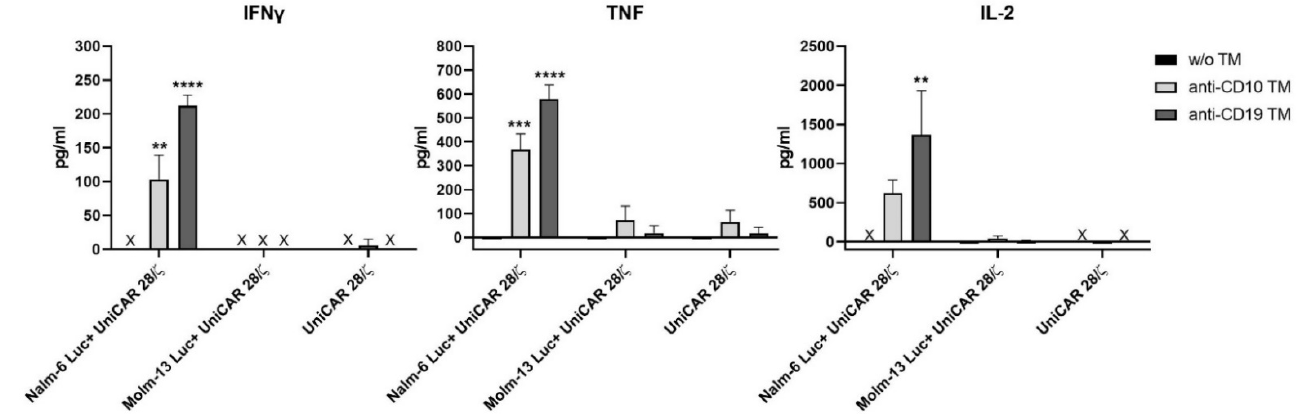
Figure 5. Cytokine release from UniCAR T ‐ cells upon engaging with Nalm ‐ 6 Luc cells via anti ‐ CD10 TM. UniCAR T ‐ cells were incubated for 7 h, either alone or in the presence of one of the cell lines (Nalm ‐ 6 Luc or Molm ‐ 13 Luc), at 5:1 E:T ratio. There was also the addition of 50 nM of anti ‐ CD10 TM or anti ‐ CD19 TM. The cell ‐ free supernatants were then collected and the cytokines were analyzed by Enzyme ‐ Linked Immunosorbent Assay (ELISA). Data is shown as mean ± SD of three independent T ‐ cell donors (** p < 0.0021, *** p < 0.0002, **** p < 0.0001; comparison to sample w/o TM; One ‐ way ANOVA with Dunnett’s multiple comparison test).